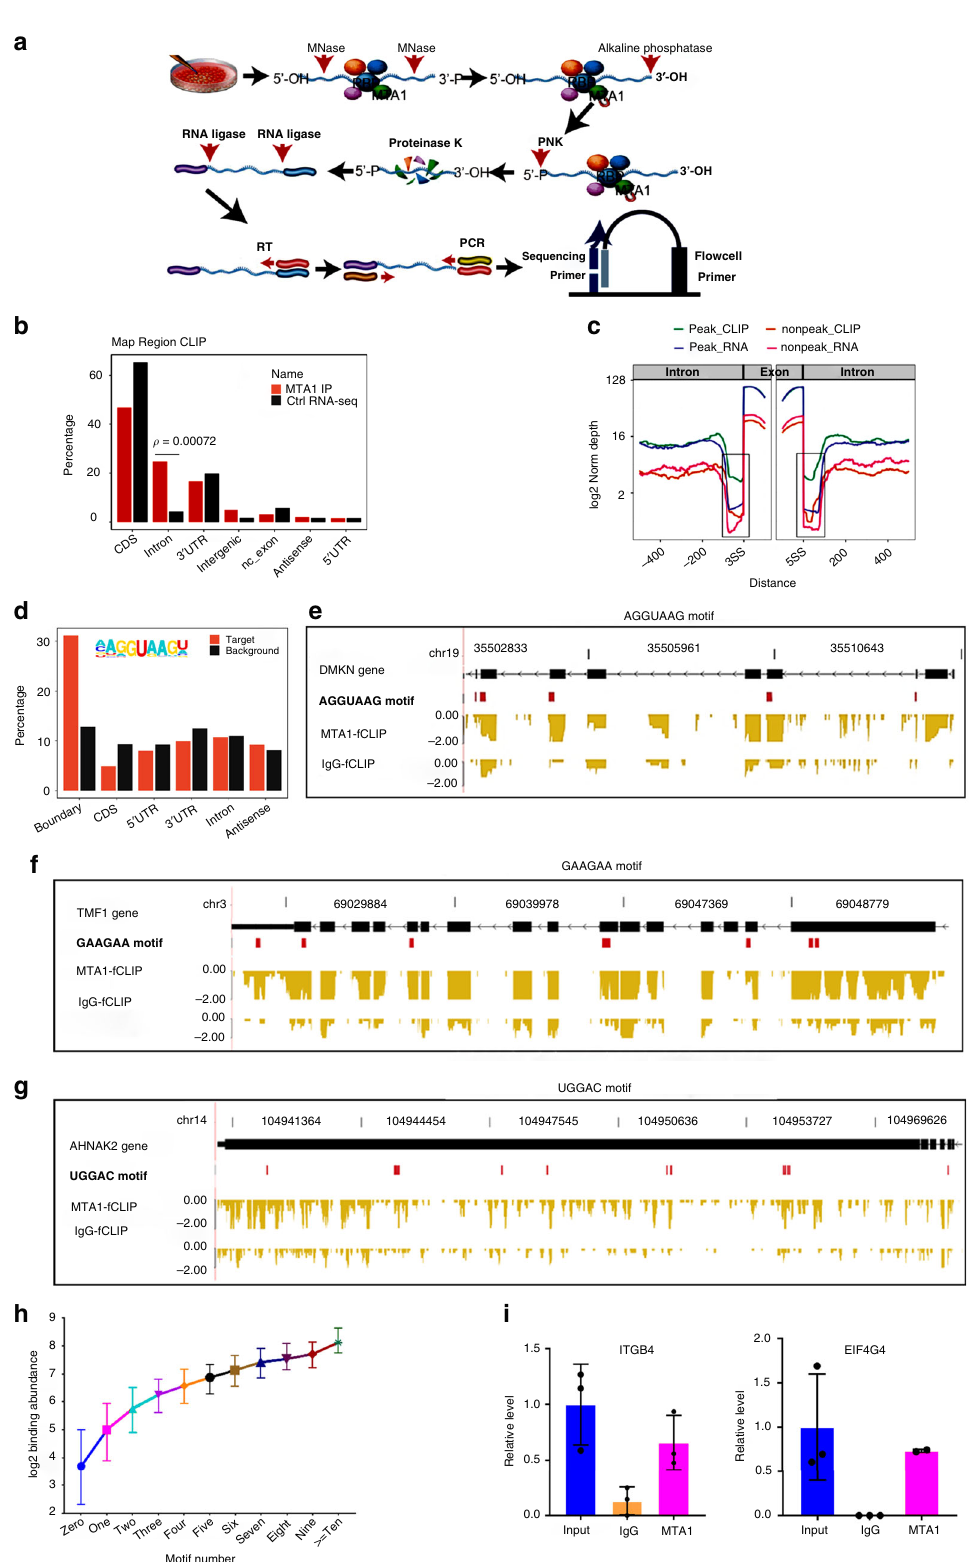
the abundance and AS pattern of target